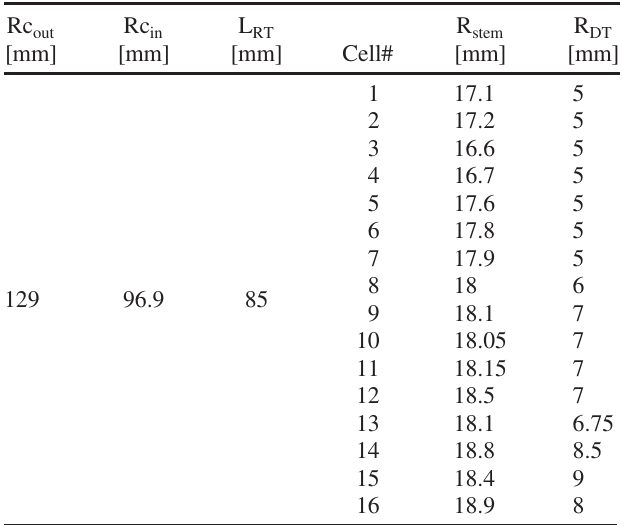
TABLE II. Dimensions and parameters of optimized IH cavity. The cavity radii at the down- and upstream ends are labeled Rc and Rc , respectively. The ridge tuner length, the stem radius, in and the drift tube radius are labeled L respectively.